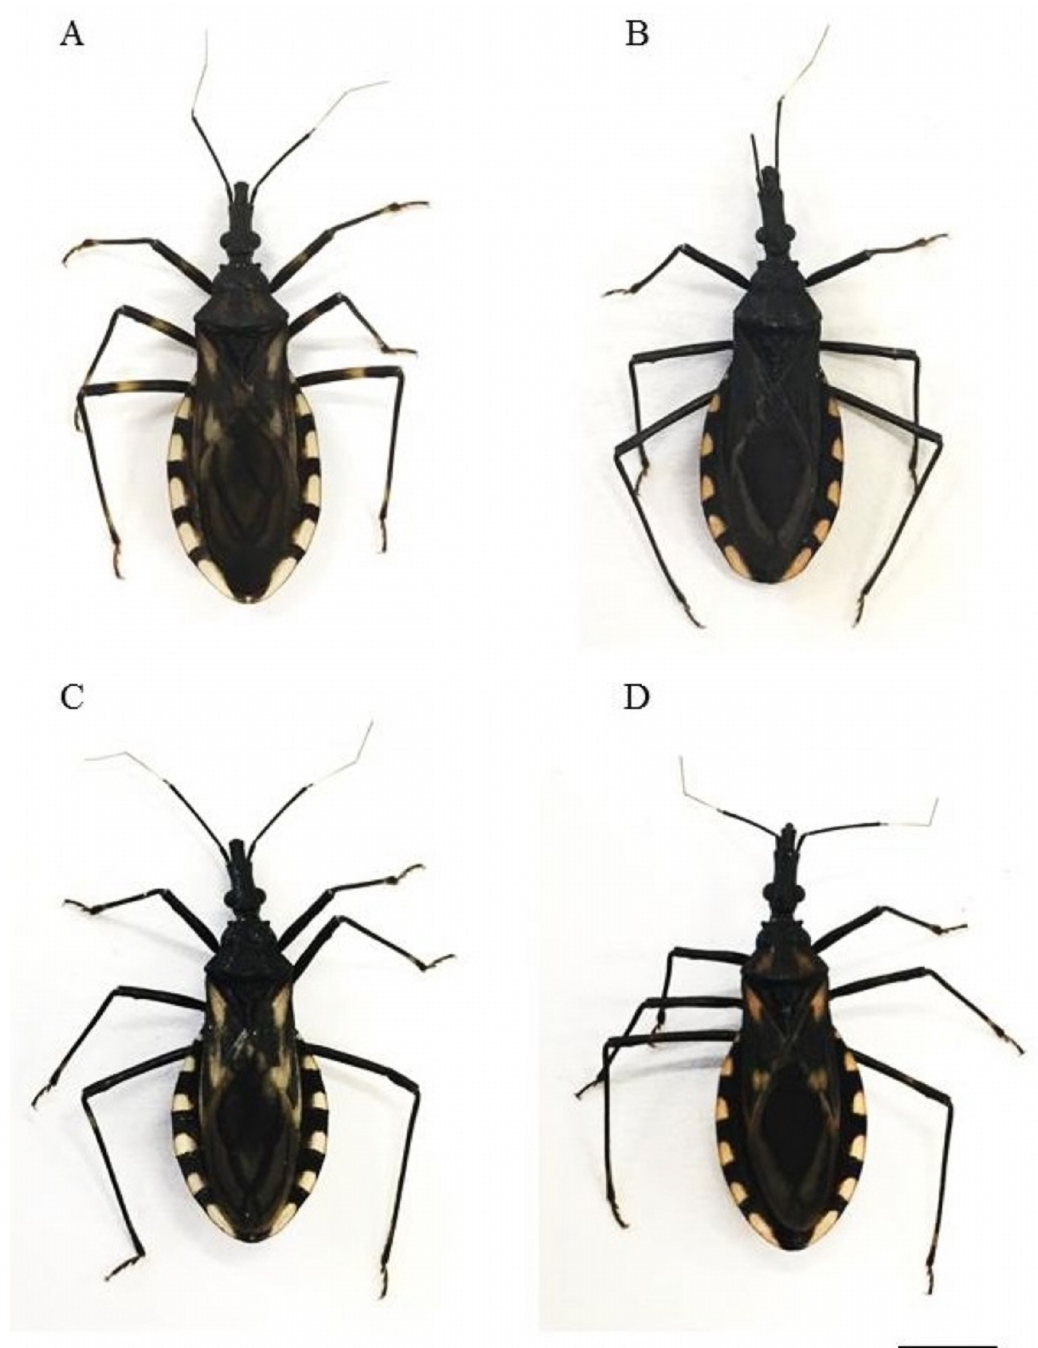
Fig 2. Hybrids resulting from experimental crosses between T . b . brasiliensis female x T . lenti male (A), T . b . macromelasoma female x T . lenti male (B), T . juazeirensis female x T . lenti male (C) and T . melanica female x T . lenti male (D). Bar: 5 cm.